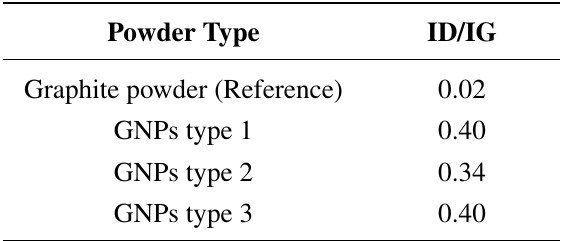
Table 1. Intensity ratios for D and G band (calculated from corresponding Raman spectra.